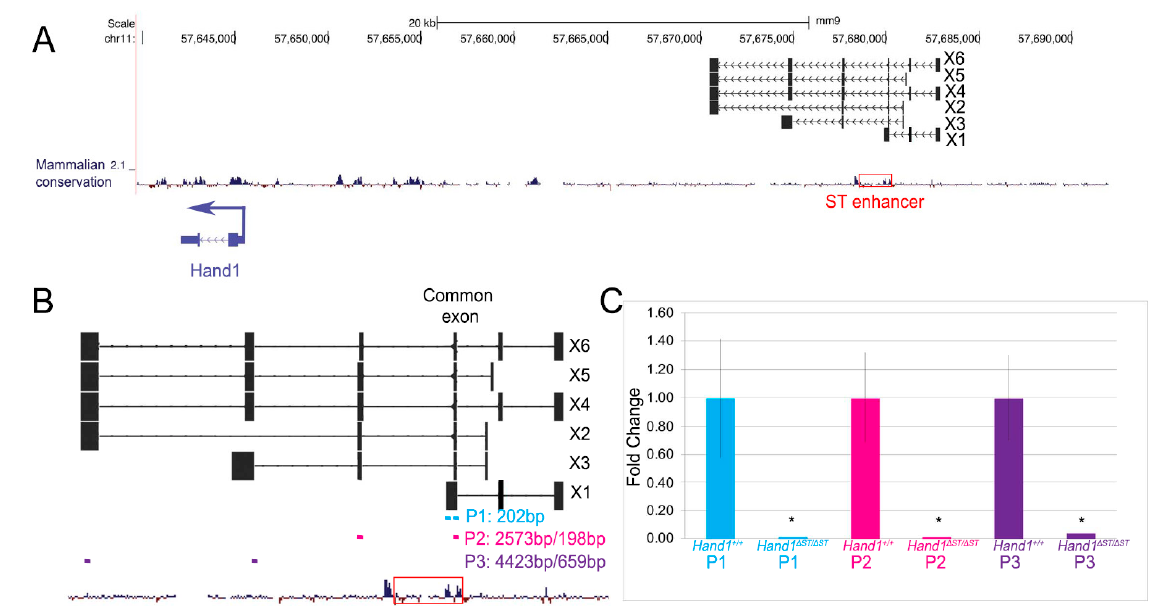
Figure 6. Loss of Putative LncRNA Family does not Affect Heart Development. ( A ) Schematic showing predicted lncRNAs X1, X2, X3, X4, X5, X6 upstream of Hand1 coding region. Red box indicating ST enhancer deletion. ( B ) Schematic showing lncRNA overlaid with ST enhancer. Common exon shared between all lncRNAs that overlaps with ST enhancer is marked. Two primer sets designed to detect lncs P1 (blue, 202bp lncRNA product size), P2 (magenta, 2573bp genomic product size, 198bp lncRNA product size), P3 (purple, 4423bp genomic product size, 659bp lncRNA product size) are marked. ( C ) qRT-PCR results to detect lncRNAs in E10.5 Hand1 +/+ and Hand1 Δ ST/ Δ ST embryos. (* indicates p ≤ 0.05). Error bars indicate standard error.